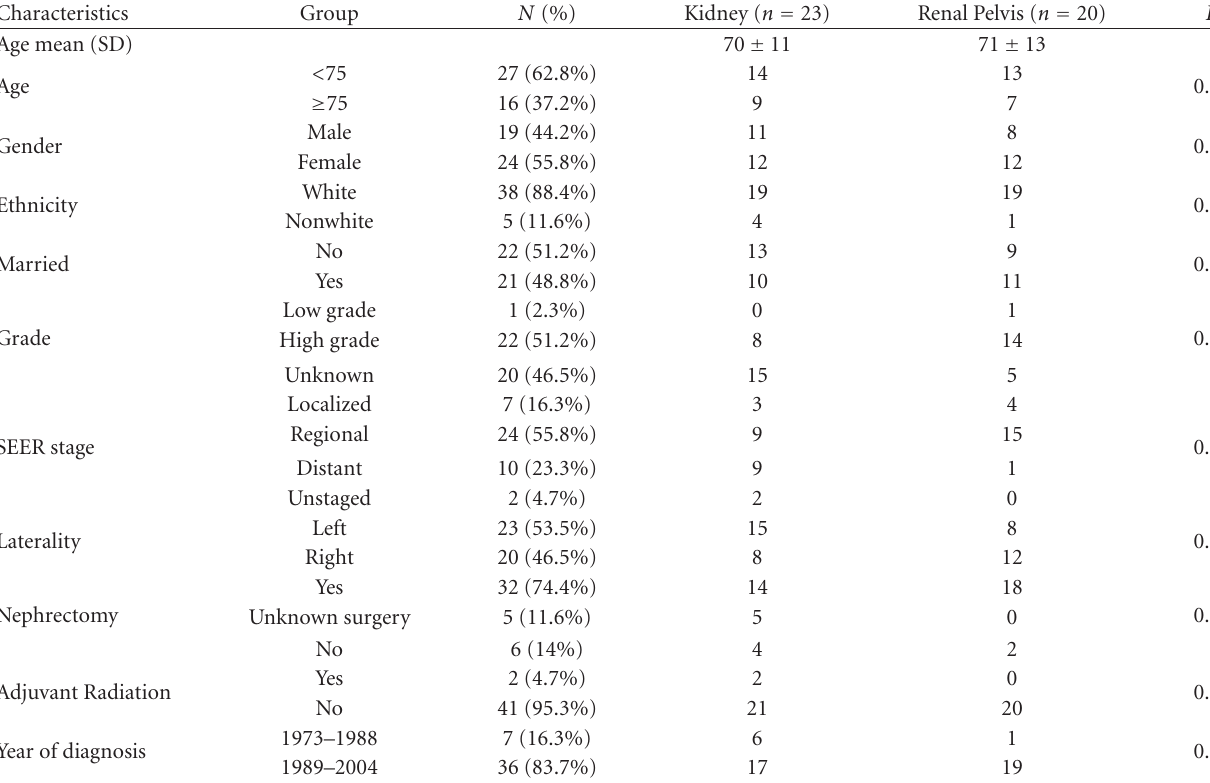
Table 1: Demographic and clinical characteristics of 43 patients with carcinosarcoma of kidney and renal pelvis (CSKP).